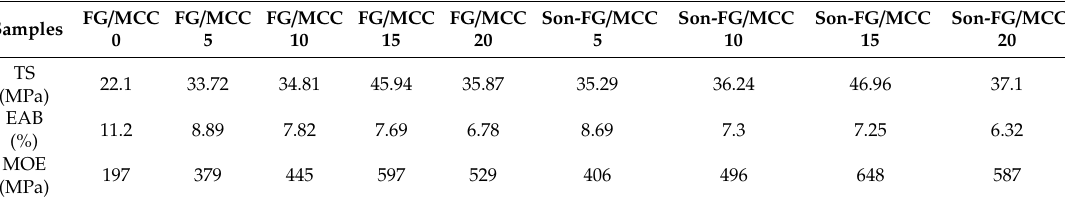
Figure 6. Tensile strength ( a ), elongation at break ( b ), and elasticity modulus tensile strength ( c ) for pure fish glue film and composite films reinforced with 0 wt% MCC, 5 wt% MCC, 10 wt% MCC, 15 wt% MCC, 20 wt% MCC and ultrasonic of that. Table 4. The tensile strength, elongation at break, and elasticity modulus tensile strength of pure fish glue film and composite